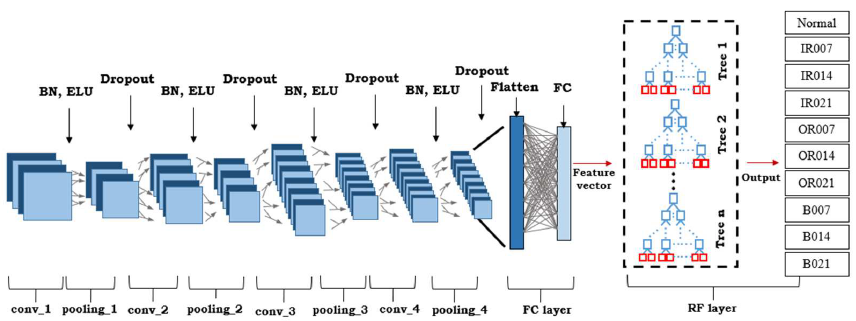
Figure 6. Structure of the proposed 2DCNN-RF model.